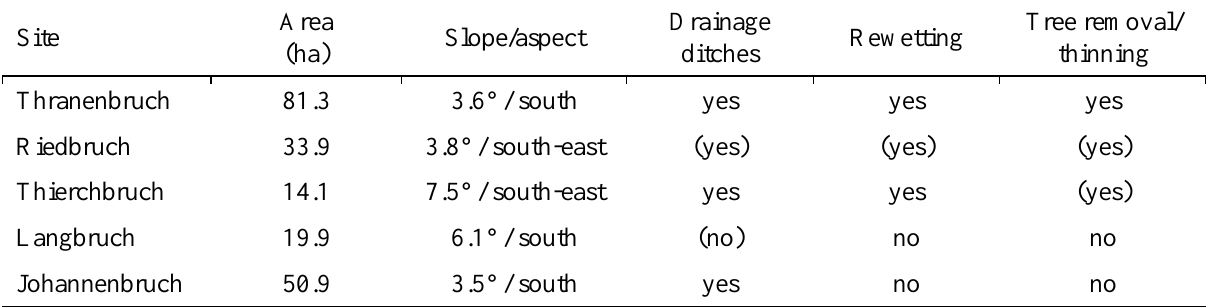
Table 1. Characteristics of monitoring sites. Brackets indicate small parts of the peatland for rewetting activities or tree removal/thinning, or a less pronounced drainage ditches